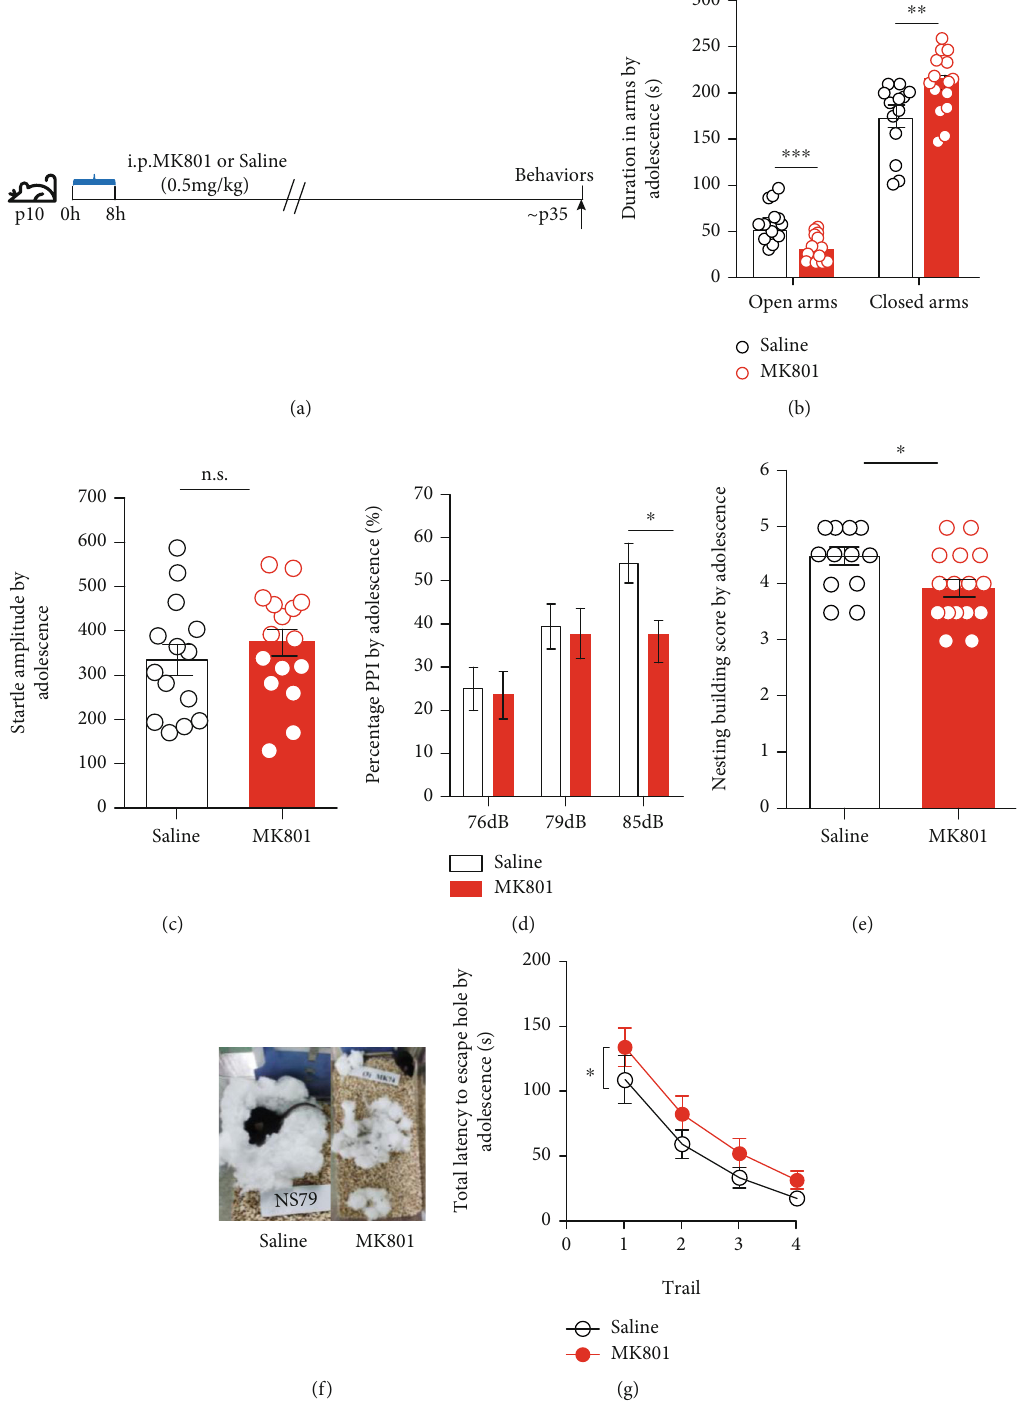
Figure 1: Mice administrated with MK-801 on PND 10 showed schizophrenia-like behaviors in adolescence. (a) C57BL/6 male mice intraperitoneally received two consecutive injections of MK-801 (0.5 mg/kg) or saline on PND 10 with an interval of 8h. Behavioral tests were performed from PND 35. (b) Time spends in the open ( p < 0 : 001 ) and closed arms, p = 0 : 0069 . (c) There was no signi fi cant di ff erence in the baseline startle response amplitude between MK-801-treated and control groups, p = 0 : 4083 . (d) Prepulse inhibition was signi fi cantly inhibited at 85dB in MK-801-injected mice ( p = 0 : 0334 ). (e) Nesting building score was signi fi cantly lower in MK-801- treated mice, p = 0 : 0154 . (f) The nesting building image between MK-801-treated and control mice. (g) MK-801-treated mice showed longer latency in entering the escape chamber ( F ð = 6 : 109 , p = 0 : 015 , two-way ANOVA). Data were represented as mean ± SEM . n = 1,112 Þ 14 of saline and n = 16of MK801 . ∗ p < 0 : 05 , ∗∗ p < 0 : 01 , ∗∗∗ p < 0 : 001 . Student ’ s t -test for two groups ’ comparison. Two-way ANOVA by post hoc Tukey ’ s multiple comparison for two factors and two group